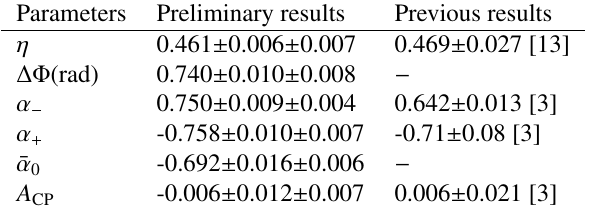
Table 1. Preliminary BESIII results for the decay asymmetry parameters for J /ψ → Λ ¯ Λ